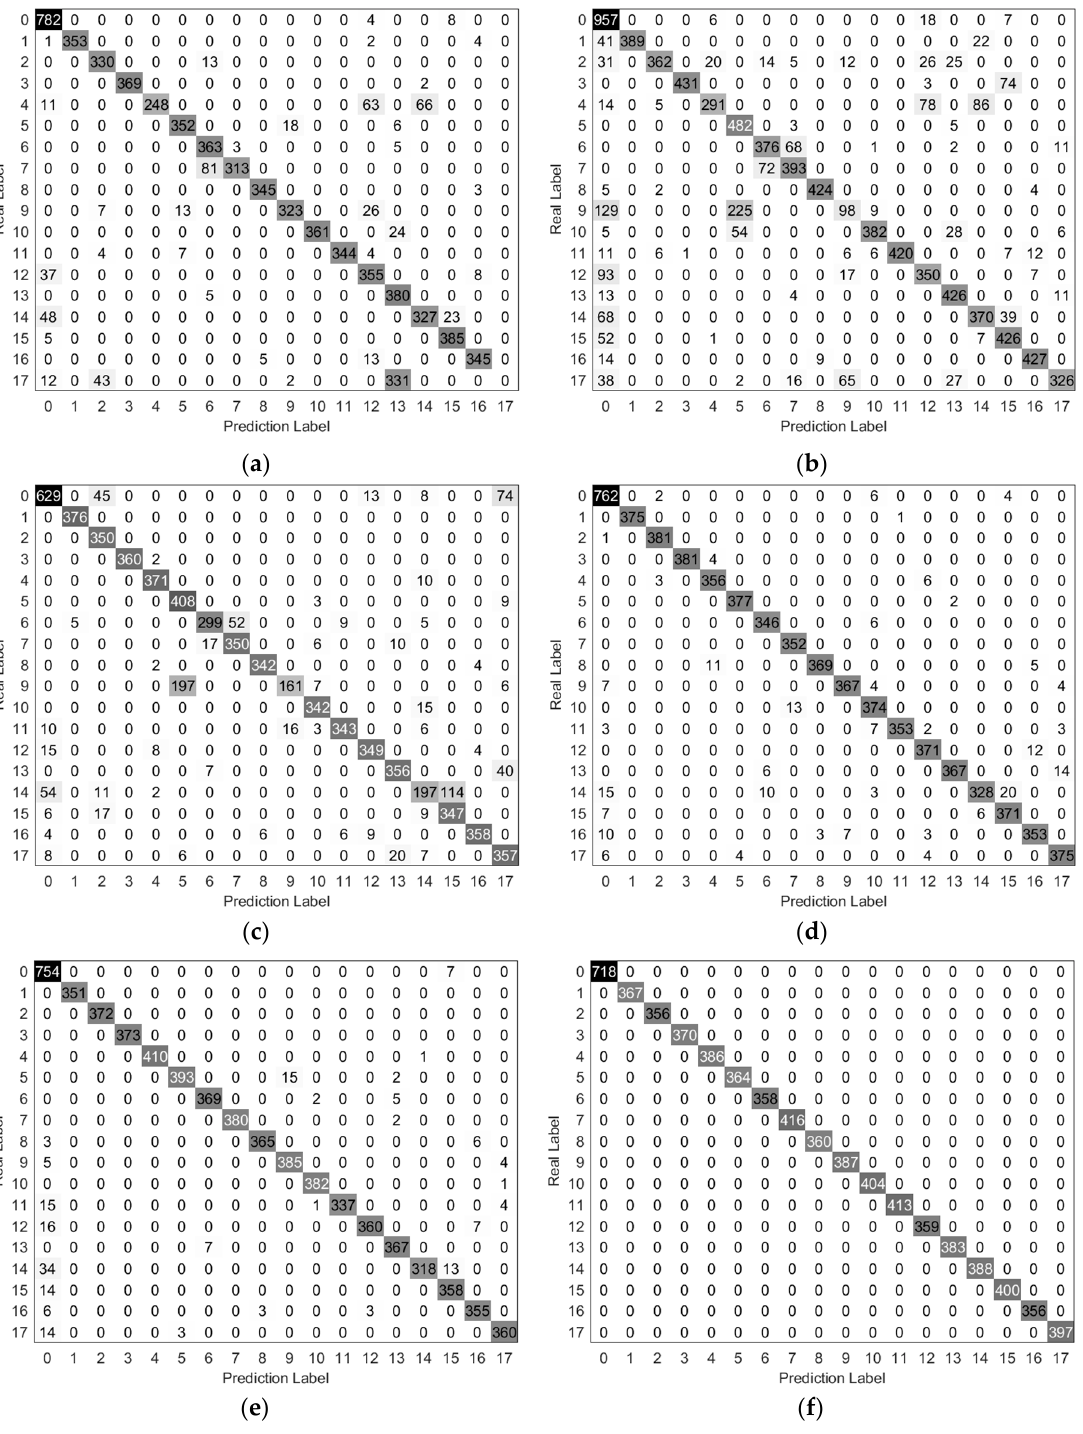
Figure 15. Confusion matrix of classification results of different algorithms. ( a ) DT algorithm; ( b )